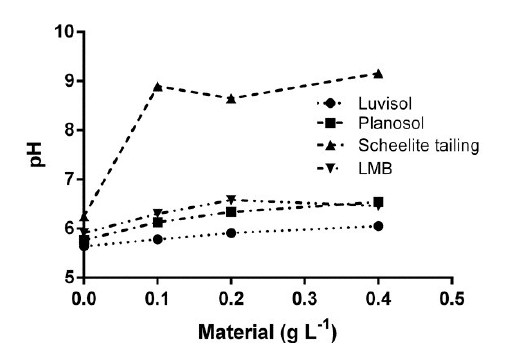
Figure 2. Influence of the addition of 0, 0.1, 0.2 and 0.4 g L -1 of adsorbent materials to distilled water on the pH of the solution. LMB=Lanthanum Modified Bentonite.